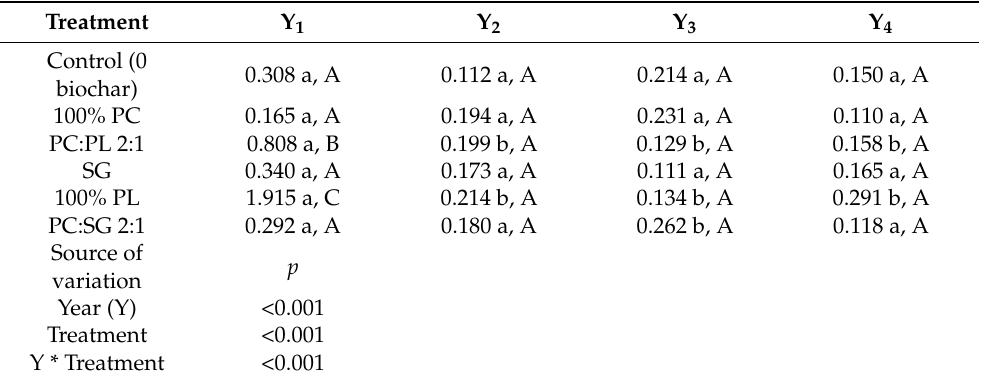
(means computed from n =4; Y = year; PC = pine chip, PL = poultry litter; SG = switchgrass